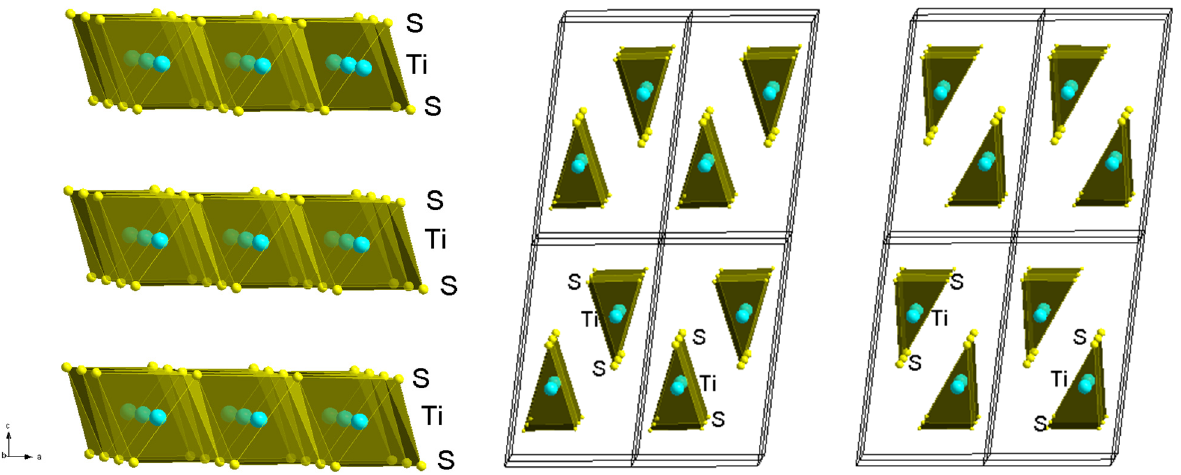
Figure 1. Structure views of TiS 2 , and the A- and B-variants of TiS 3 (From left to